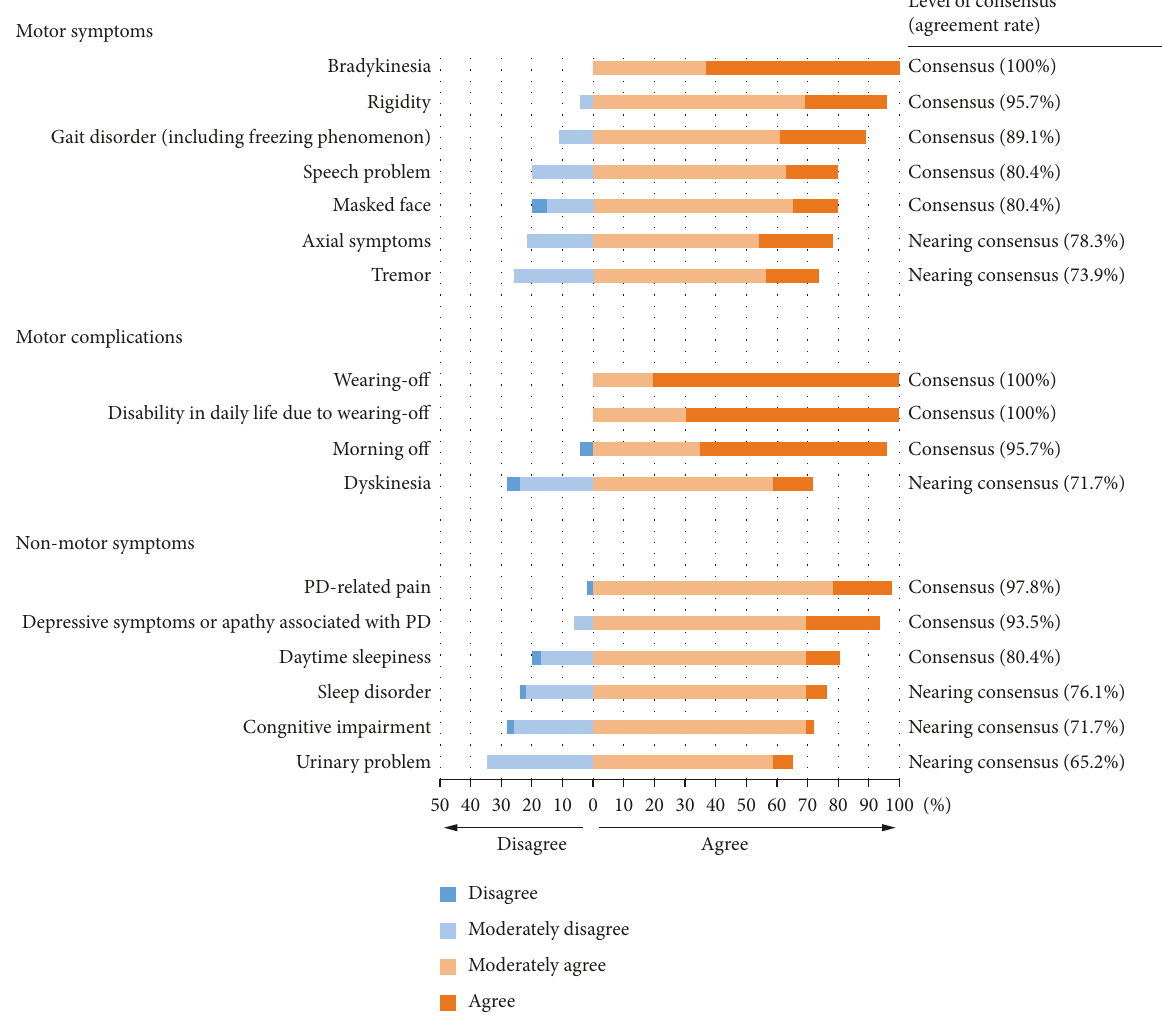
Figure 2: Summary of the optimal patient type with wearing-off for safinamide. Motor symptoms (Q1): optimal patient based on motor symptoms related to wearing-off; motor complications (Q2): optimal patient type based on motor complications; non-motor symptoms (Q9): optimal patient type based on non-motor symptoms associated with wearing-off. PD :Parkinson’s